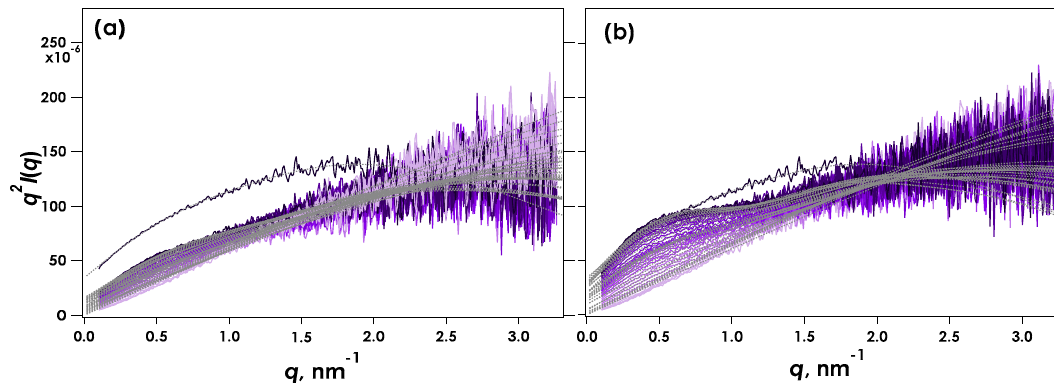
Figure 7. Kratky plots obtained for time-resolved SAXS during CLEX gelation of 1% alginate in aqueous HEPES buffer including CaEDTA and ZnEDDA at Ca 2+ = 30 mM and pH = 8.0. The results ( a ) and ( b ) correspond to independent measurements under the same experimental conditions. The profiles show data recorded every 5 s and the total trace times are 180 s. Solid black lines indicate SAXS obtained from fully reacted samples following 10 h reaction time.